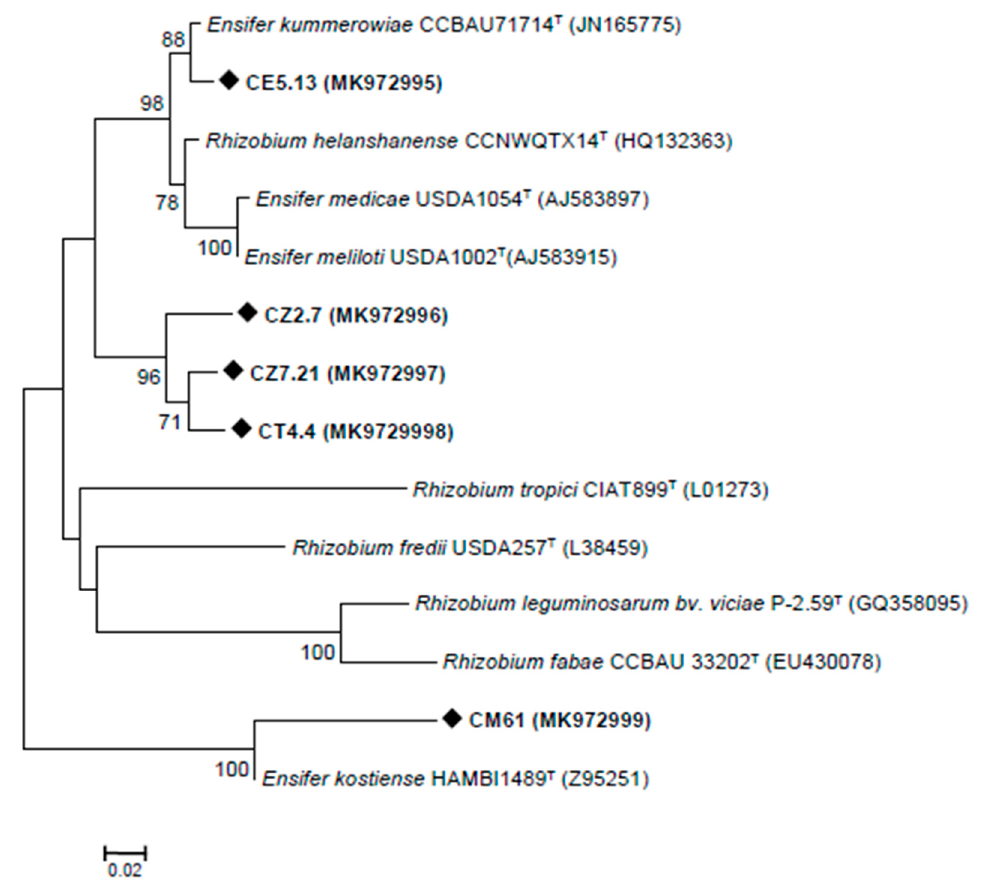
Figure 3. Molecular phylogenetic analysis using the neighbour-joining method of C. villosa root nodule isolates for the nodD gene. Significant bootstraps (70%) are indicated as percentages (1000 replications). Scale bar = 0.02 nucleotide divergence.